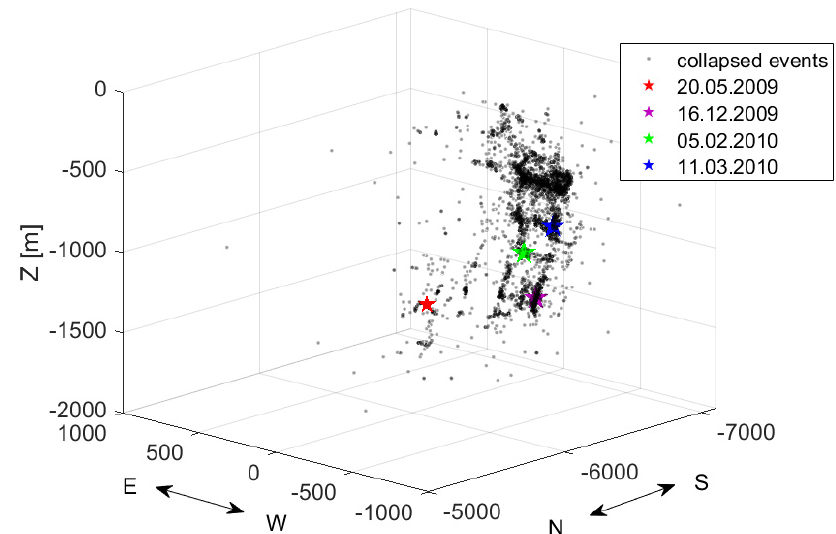
Figure 7. Seismic cloud after collapsing procedure. The figure shows also the location of the foci of the four largest events recorded during mining of the seam.